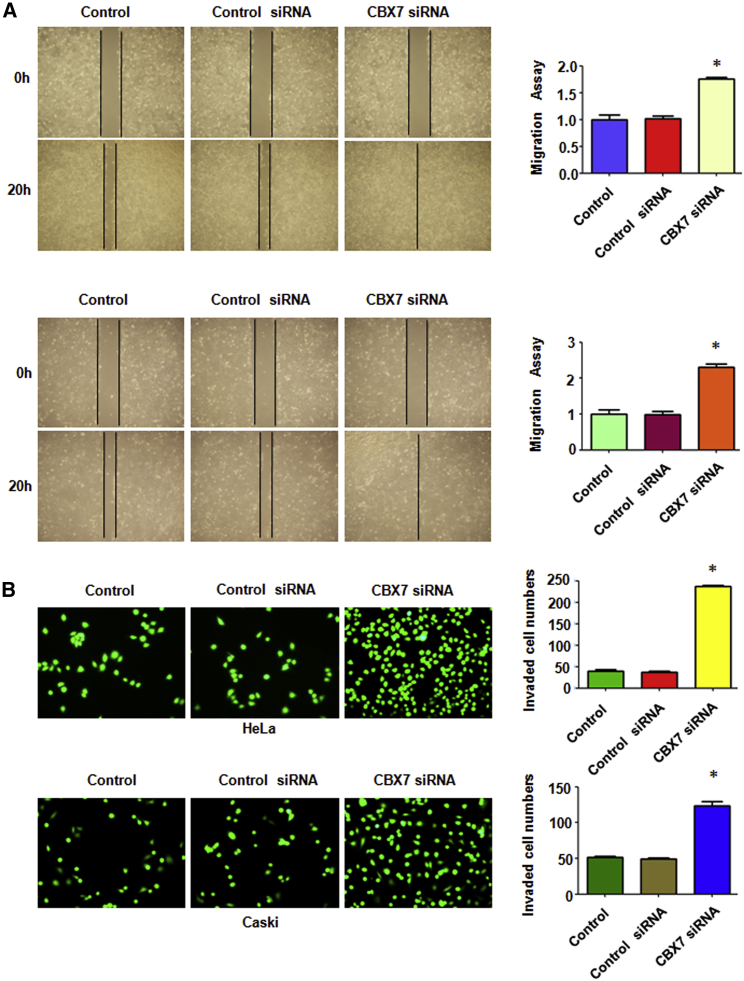
Downregulation of CBX7 Promotes Cell Migration and Invasion(A) Left: The ability of cell migration was determined via a wound-healing assay in cervical cancer cells after CBX7 siRNA transfection. Right: Quantitative results are illustrated for left. *p < 0.05 versus control group. (B) Left: the ability of cell invasion was measured via Transwell assay in cervical cancer cells after CBX7 siRNA transfection. Right: quantitative results are illustrated for left. *p < 0.05 versus control group.